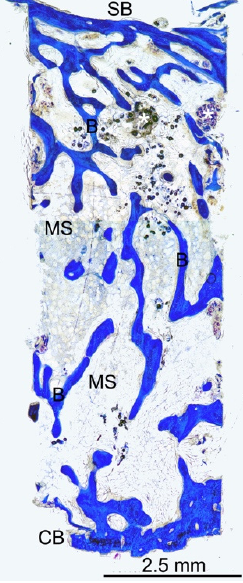
Figure 5. At low-power magnification (20×), the transversal and top and bottom sections were related to the longitudinal central section of the bone specimen to best analyze the bone microstructure of the regenerated area. The source sites of the transversal sections were visible and labelled, along with the longitudinal ones. The bone microstructure appeared to be well organized, with thicker bone trabeculae (B) that were mainly present in the bottom areas, while under the bone sinus floor, very thin and distributed bone trabeculae were highlighted. The marrow spaces (MS) were well distributed along all the sections. Several small remnants of biomaterial (*) were present mainly under the sinus floor bone. Azure B–methylene blue staining was used. (CB) crestal bone; (SB) sinus